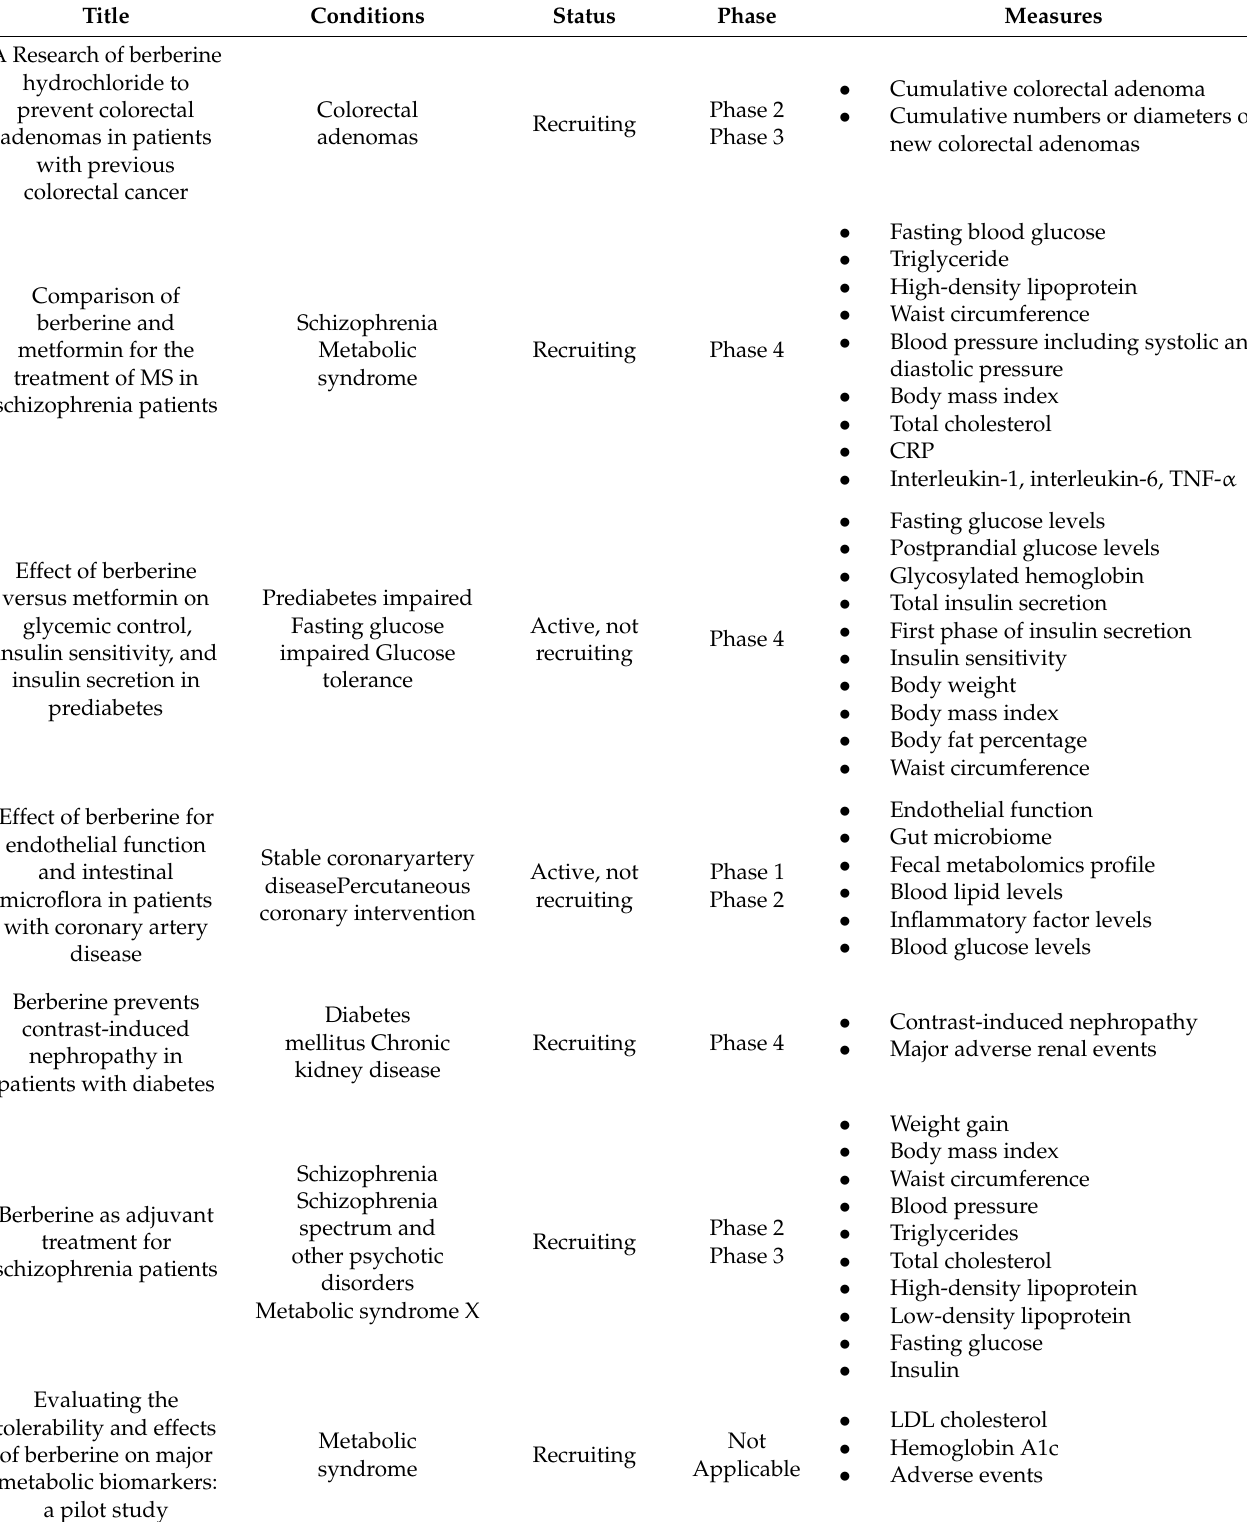
Table 2. Active clinical trials with berberine on the metabolic syndrome and its corresponding diseases based on clinicaltrials.gov (accessed on 10 Fabruary